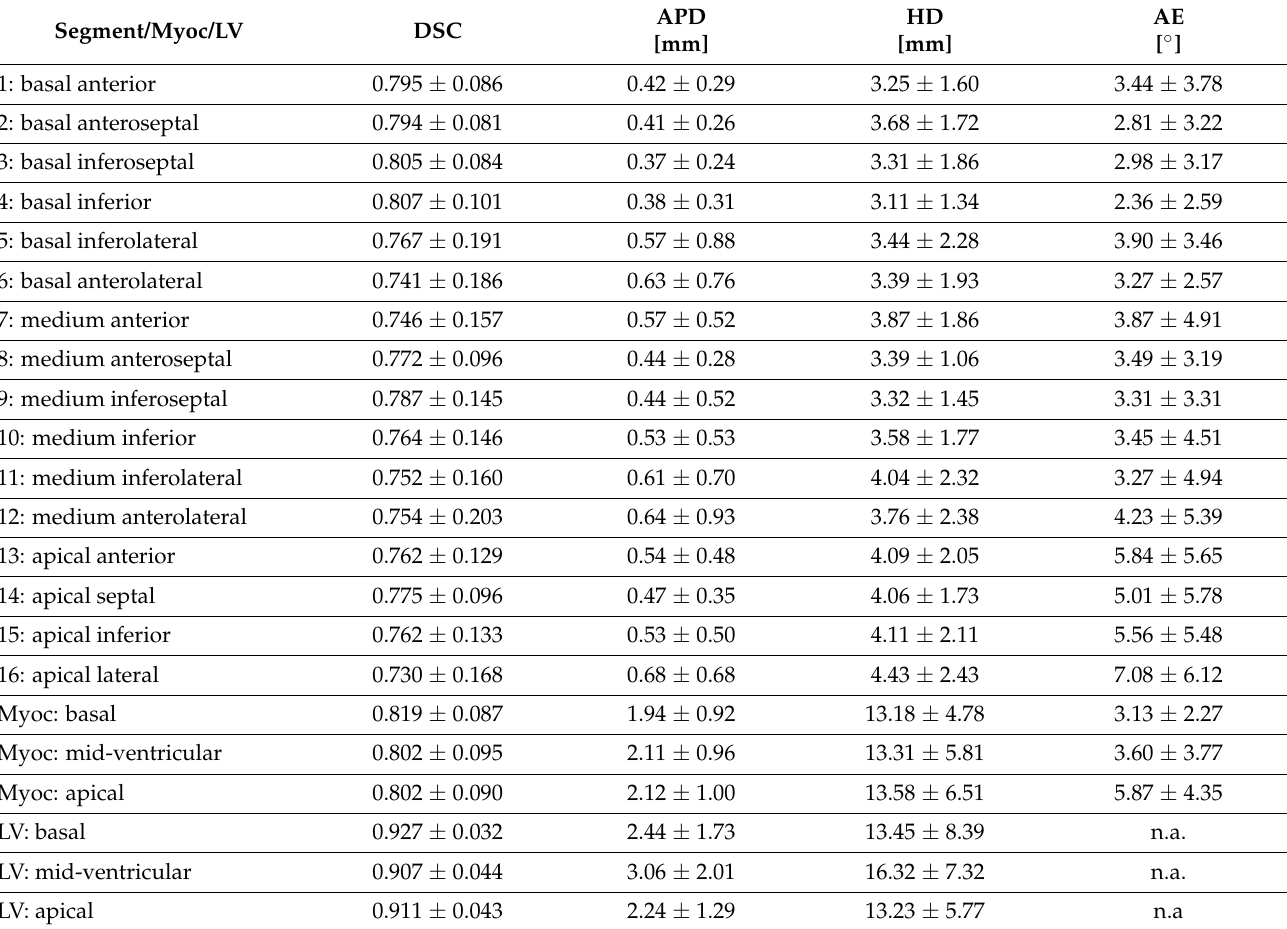
Table 1. Dice similarity coefficients (DSC), average perpendicular distance (APD), Hausdorff distance (HD), and angulation error (AE) between automated and manual segmentations calculated for each of the 16 sectors of the AHA model, for the myocardial wall (Myoc) and for LV cavity